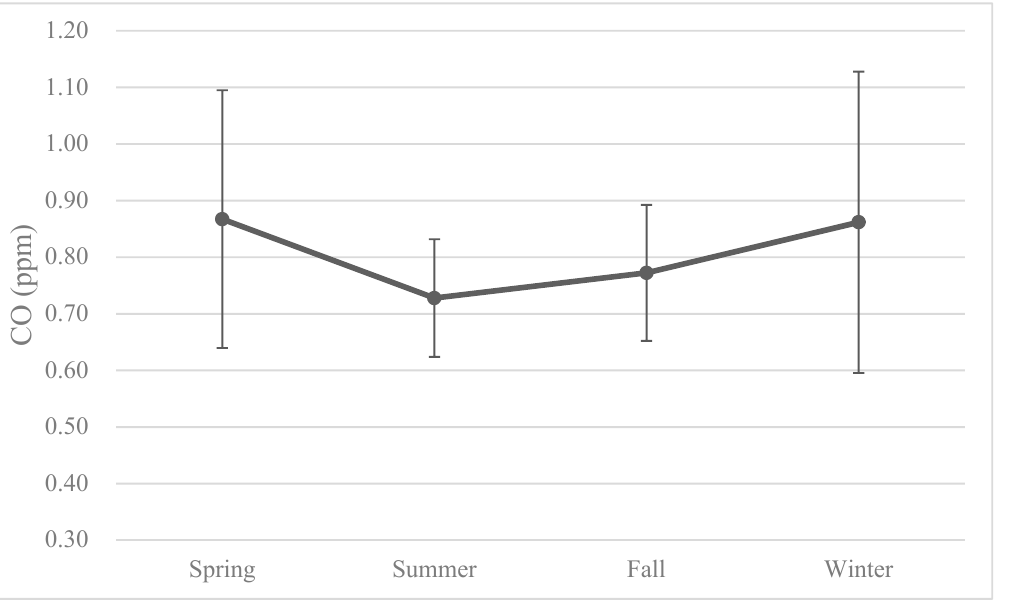
( a ) CO Figure 4. Cont